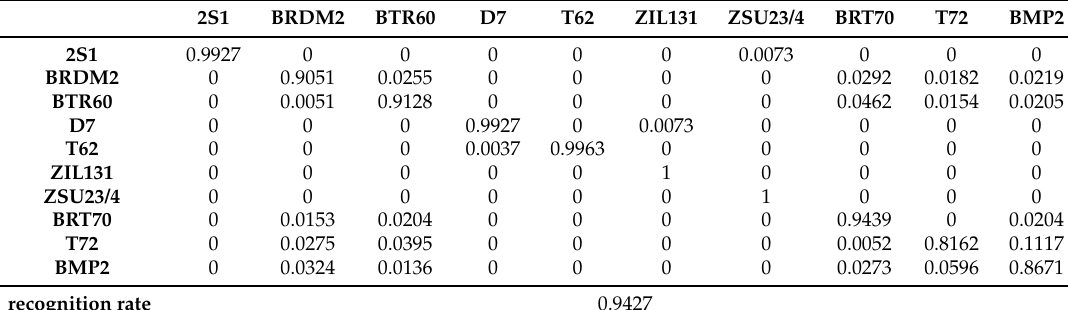
Table 14. The result of kNN based on SAR-HOG under SOC.